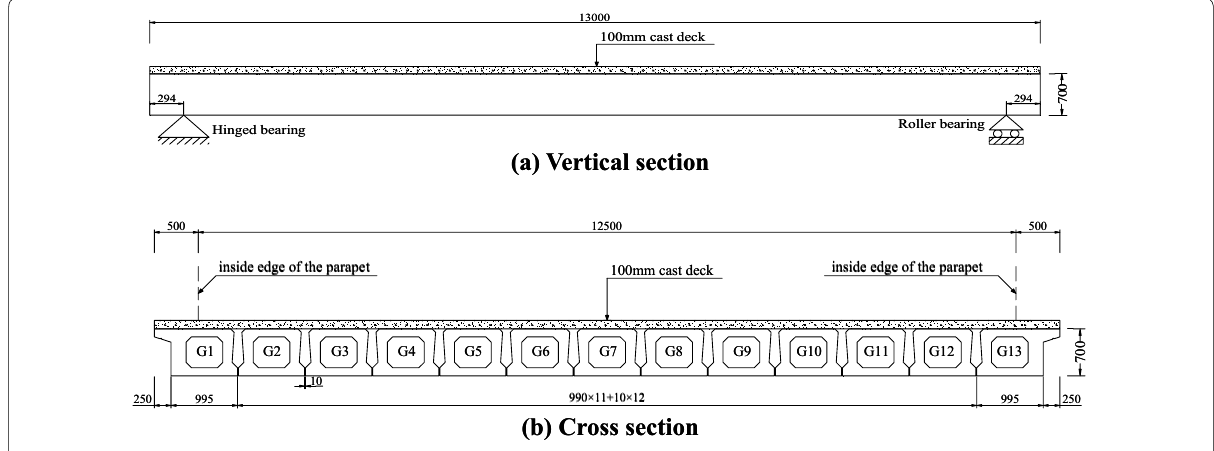
Fig. 1 Field tested bridge (units: